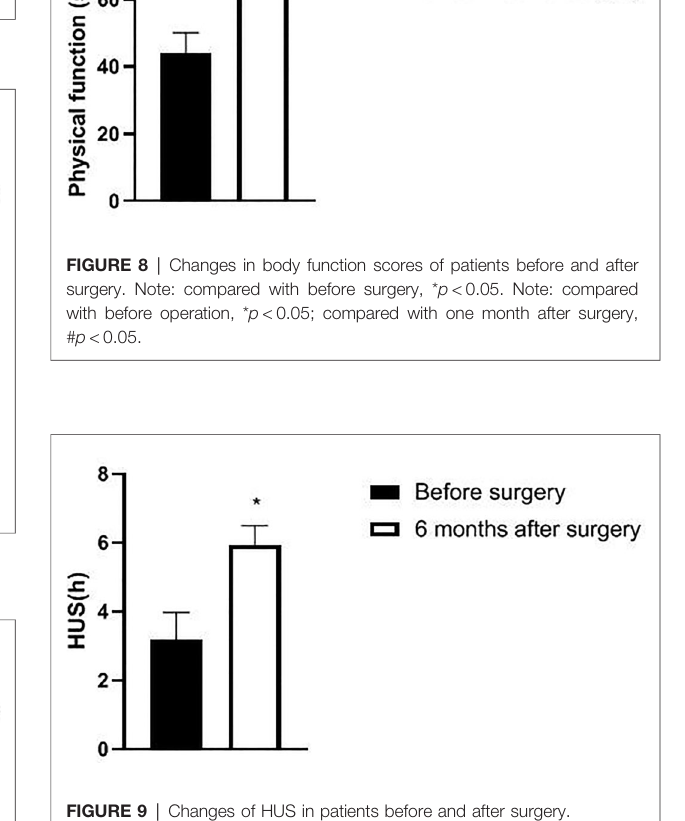
FIGURE 9 | Changes of HUS in patients before and after